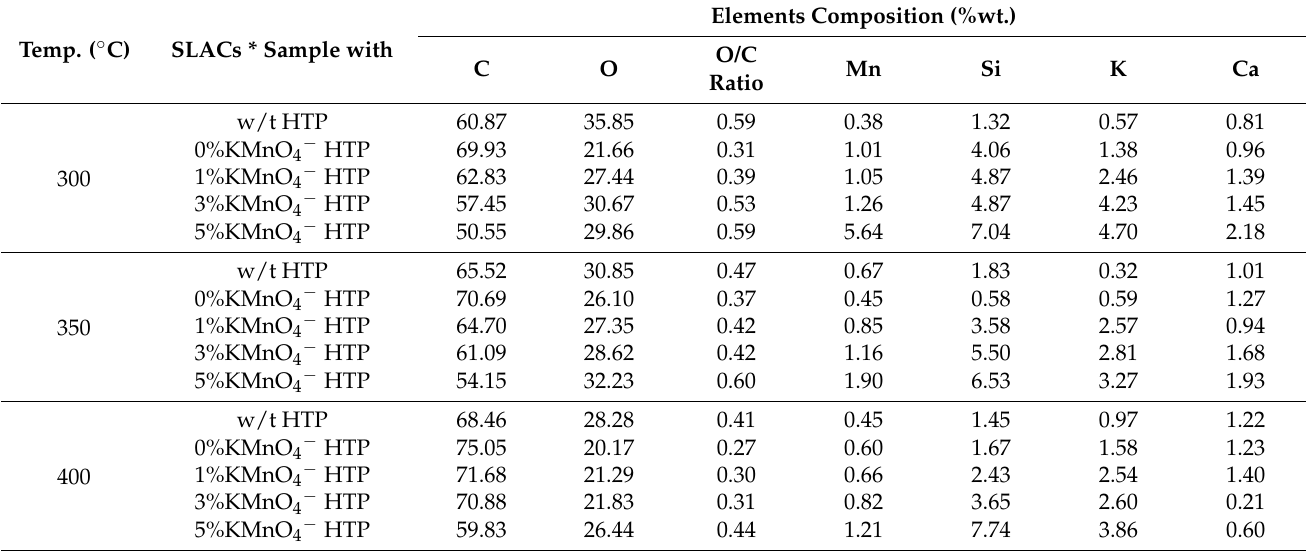
Table 1. Elemental composition of pyrolyzed products from